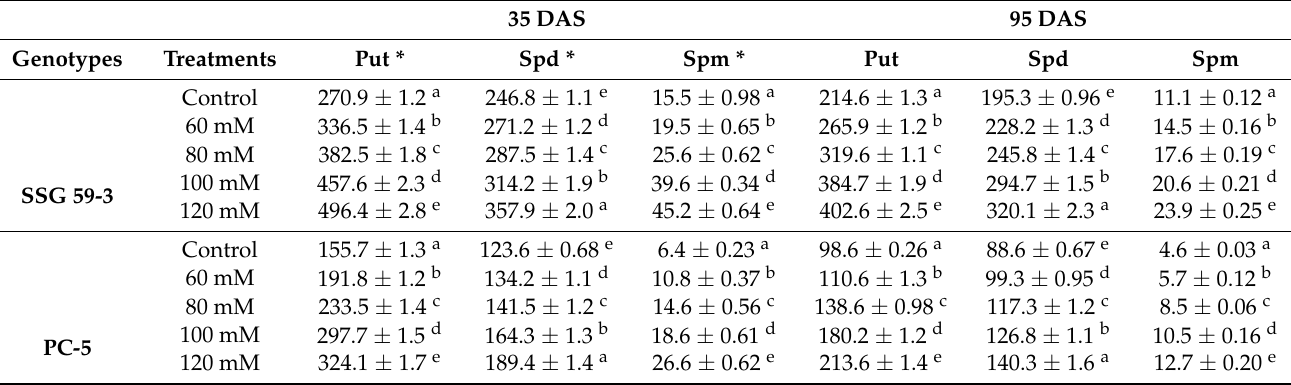
Table 3. Changes in polyamines (Put, Spd, and Spm) in the flag leaf of sorghum genotypes under salt stress.